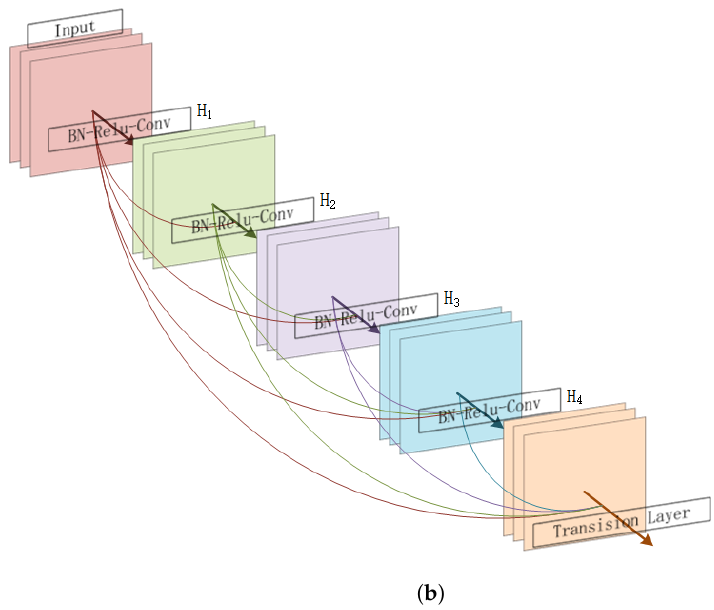
Figure A1. Above figures show the main structure of DenseNet and ResNet. ( a ) The framework of a 10 convolutional layers ResNet as sketchy plot. ( b ) A 5 layers dense block with a growth rate of k = 4. The DenseNet in our work is consist of 3 dense block like this with different layers.